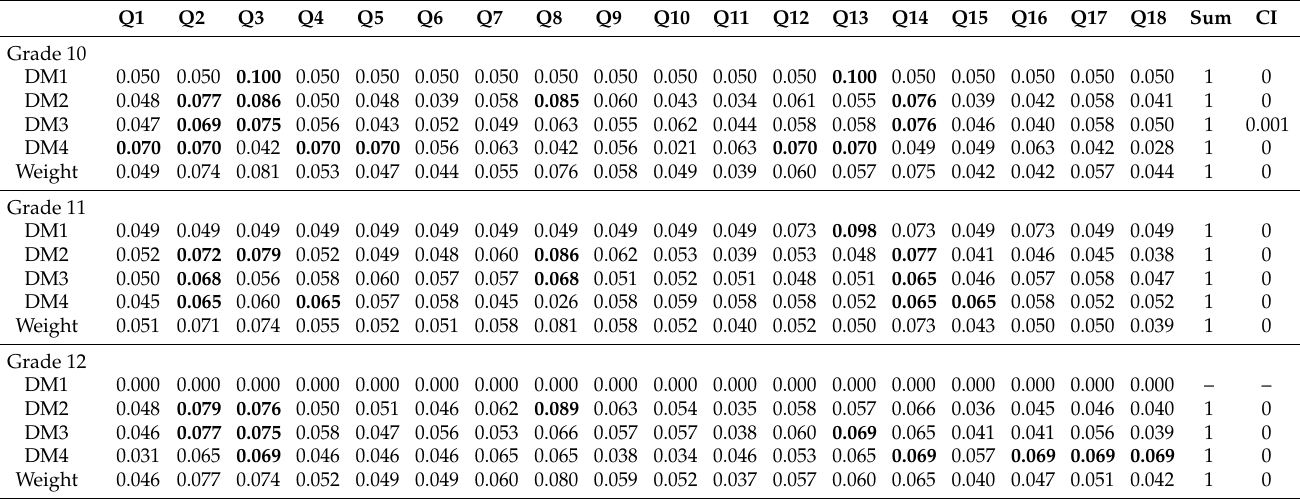
Table 5. The weight and the ranking of VGAS criteria for high school students (grades 10, 11, and 12).